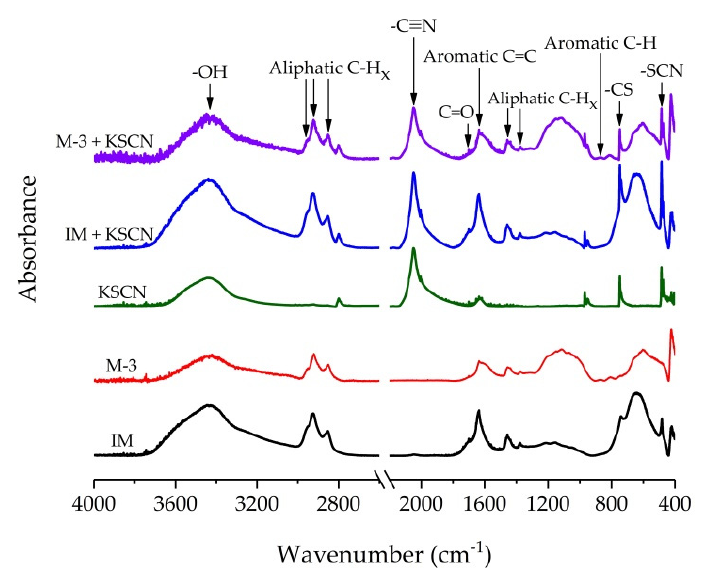
Figure 4. FTIR spectra of the Bazhenov Formation kerogen samples (IM and M-3) in transmission mode (0.8% sample in KBr pellet) in the presence of the internal standard KSCN (0.5% KSCN in KBr pellet).